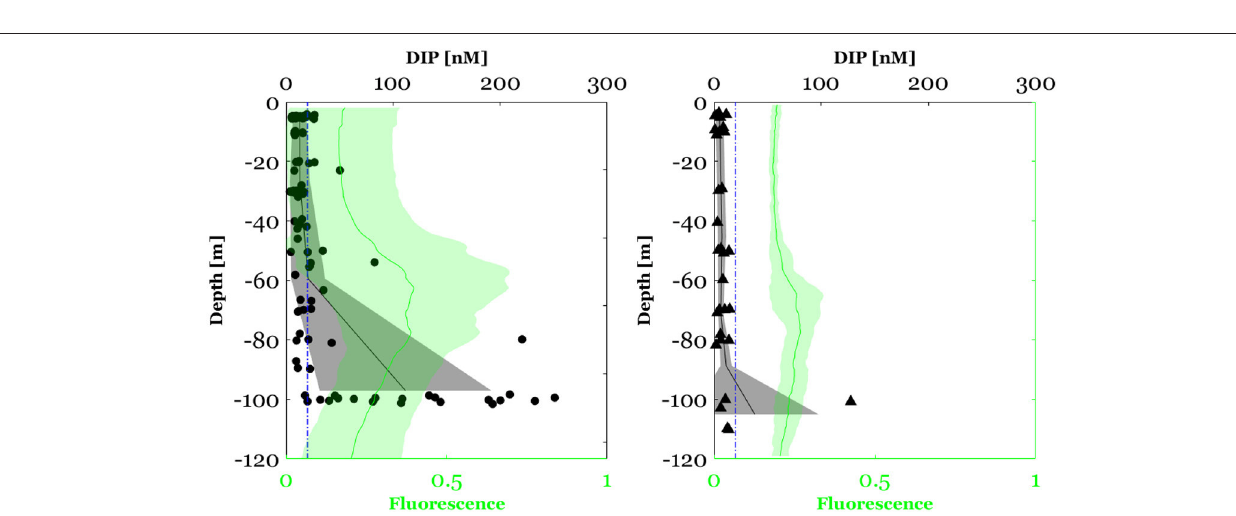
FIGURE 4 | Dissolved inorganic phosphate (DIP) concentration between the surface and 100m in the North Western Mediterranean Sea (circles) and between the surface and 120m along the E-W transect crossing Ionian and Tyrrhenian seas (triangles). The black plot represents the mean profile of DIP concentration and the bounded line the standard deviation from the mean. The blue dashed line corresponds to the limit of detection (LOD) of the conventional automated colorimetric procedure (20nM). The green plot represents the fluorescence profile (mean ± standard of